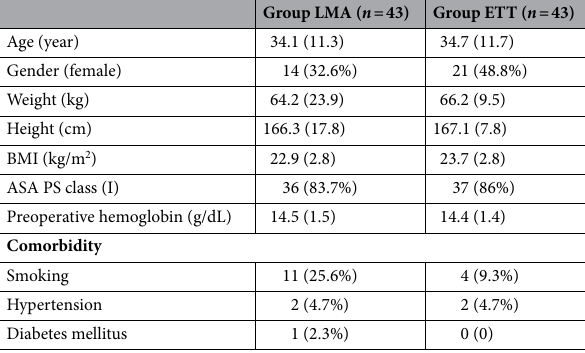
Table 1. Patients and perioperative characteristics. Data are expressed as mean (SD) or number (%). LMA laryngeal mask airway, ETT endotracheal tube, BMI body mass index, ASA PS American Society of Anesthesiologists Physical status.